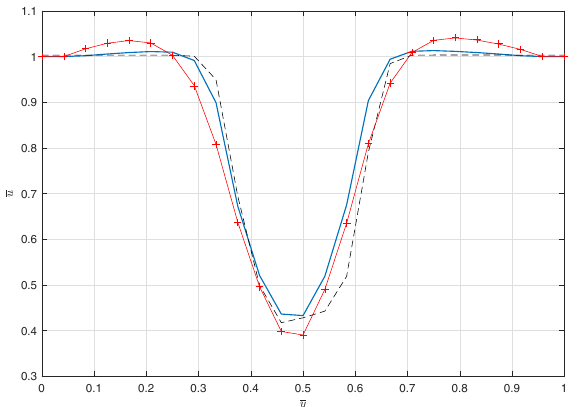
Figure 2. Results of two-turbine simulations. Normalized time- averaged wake deficit at hub height 5 D downwind from the down- wind turbine using standard 2-D Navier–Stokes equations (red crossed), our model with the adapted continuity equation (blue), and LES data (black